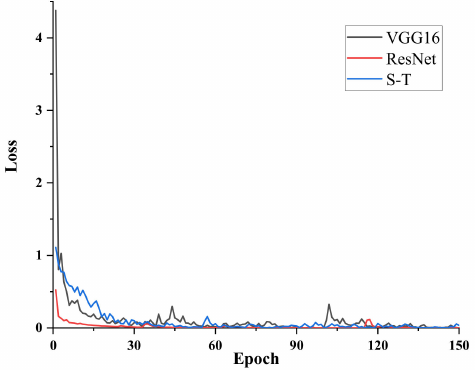
Figure 5. Loss degree change curve of each model training